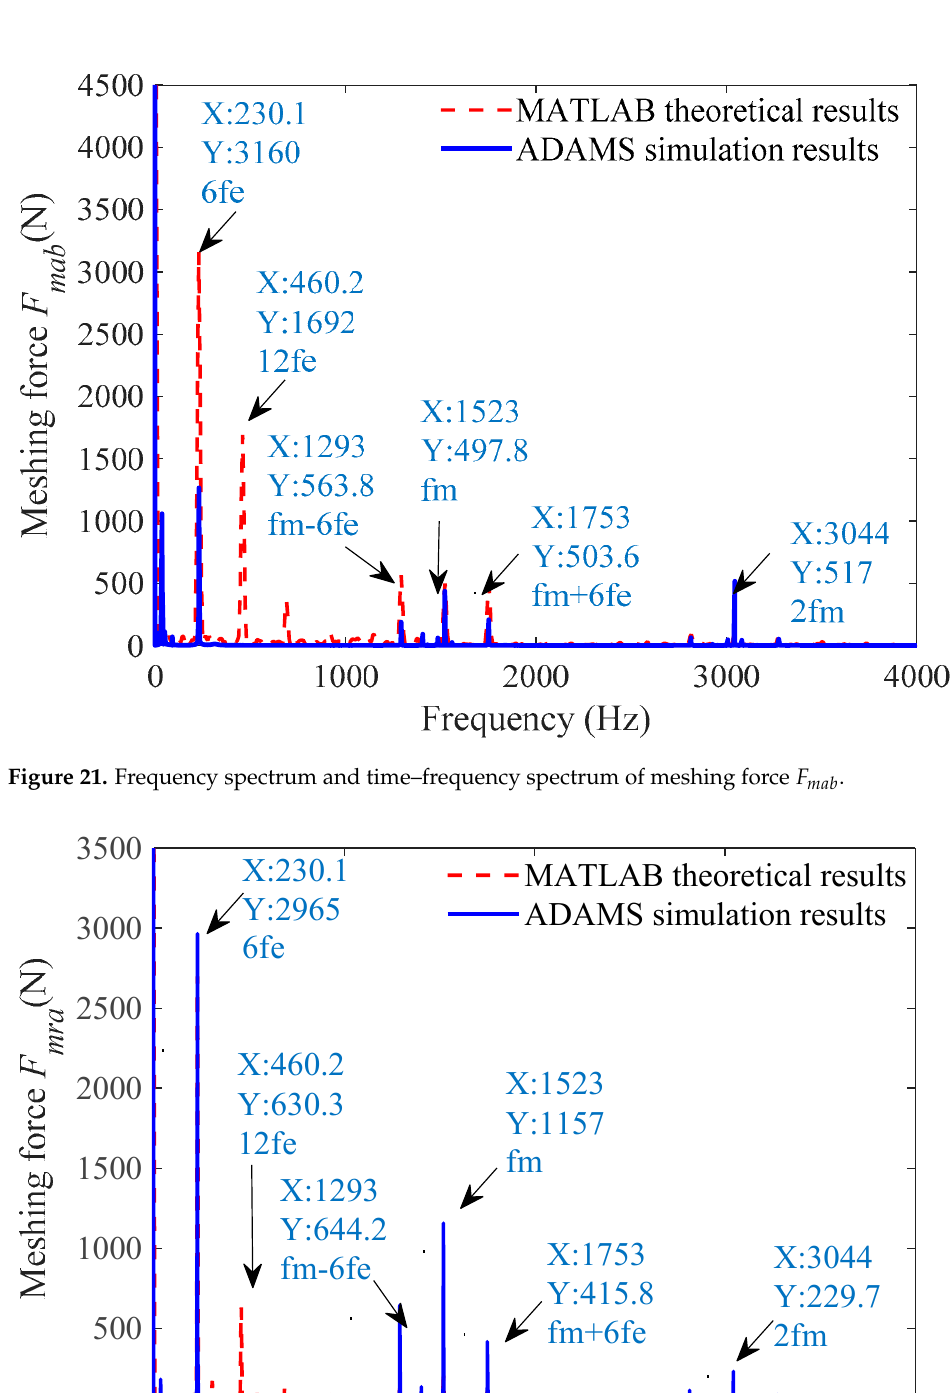
Figure 22. Frequency spectrum and time–frequency spectrum of meshing force F mra